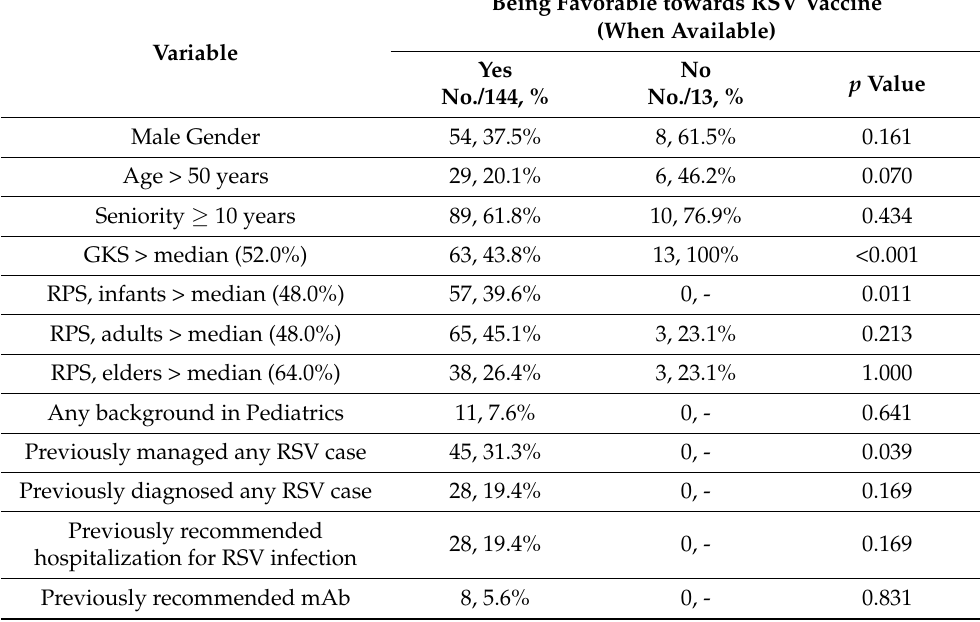
Table A5. Association of being favorable towards RSV vaccines with main variables (univariate analysis, chi-squared test with Yates’